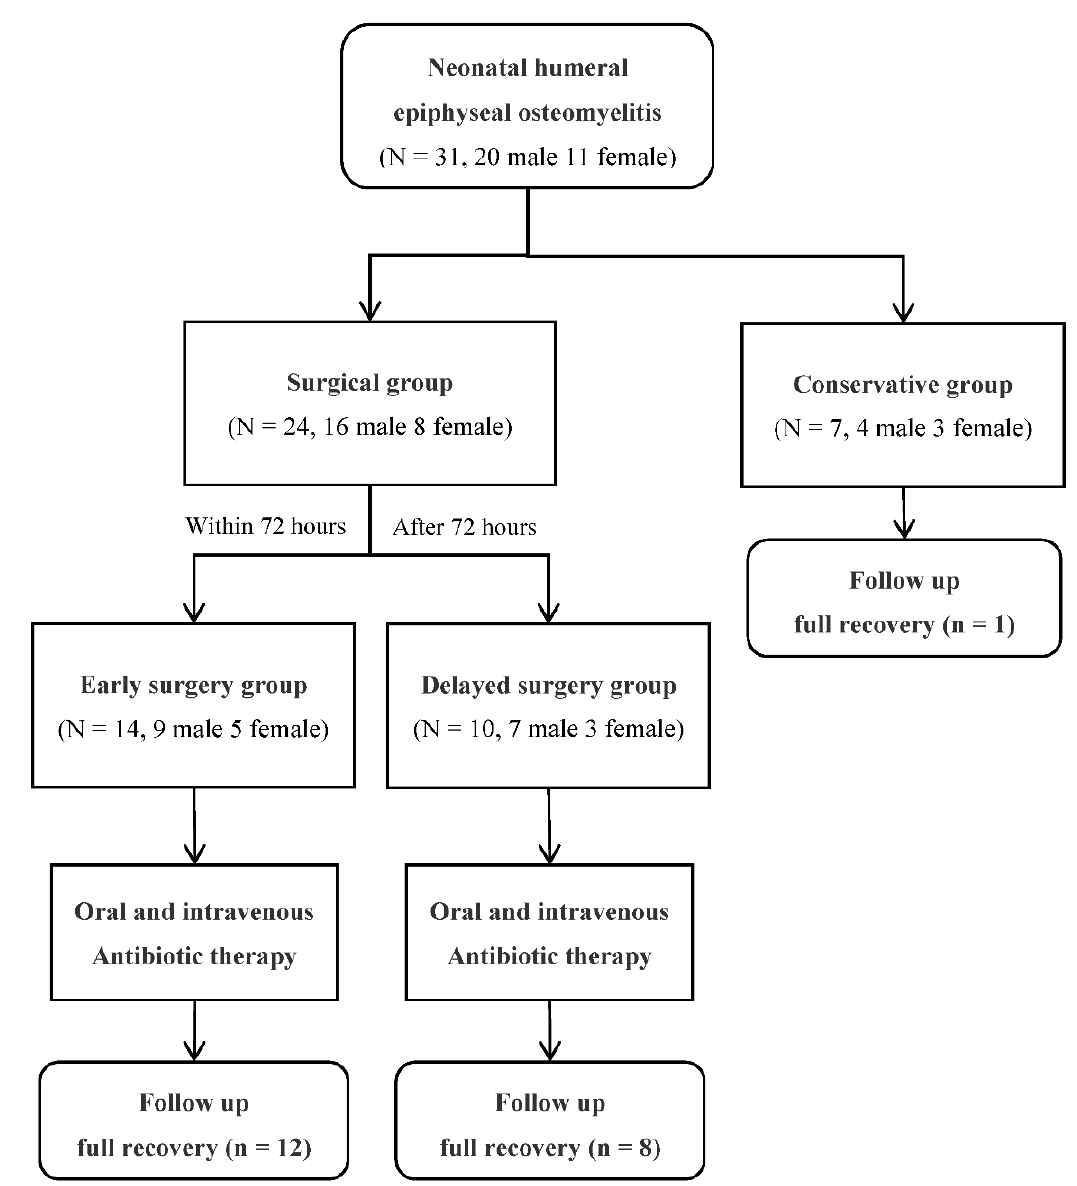
Figure 4. Flowchart of this study. Table 1. Characteristics of the patients.